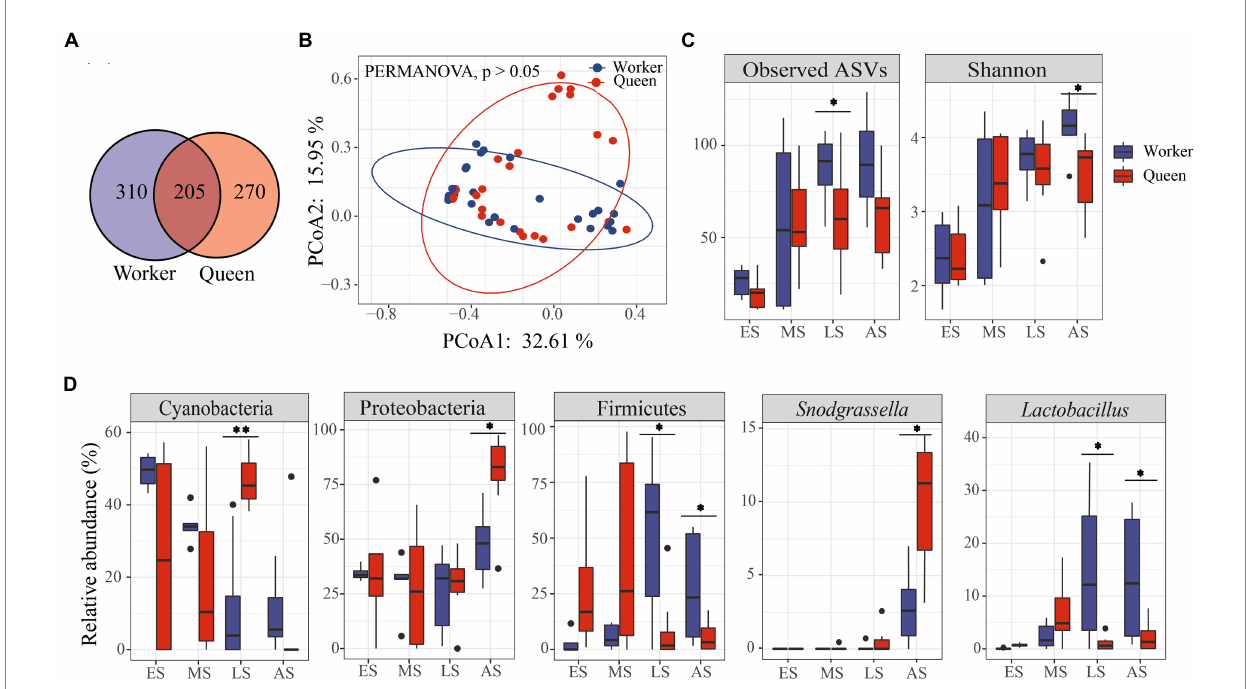
FIGURE 3 The composition and diversity of microbiota in Bombus terrestris . (A) Venn diagram of common amplicon sequence variants (ASVs). Circle A represents worker samples; circle B represents queen samples. (B) PCoA plot based on Bray-Curtis distance metrics depicting the differences in microbial community structure between worker and queen bumble bees. (C) Alpha diversity (ASVs and Shannon indices) of microbiota between workers and queens (Wilcoxon test, * represents p < 0.05). (D) The relative abundance of phyla and genera significantly differed between workers and queens (Wilcoxon test, * represents p < 0.05).